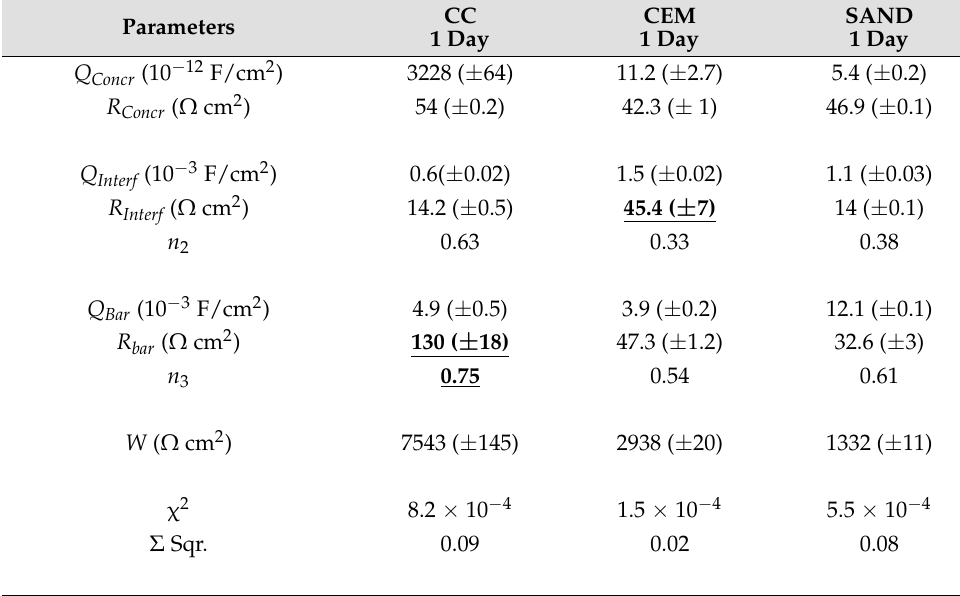
Table 3. Impedance parameters determined using equivalent circuit (EC) shown in Figure 8 with steel bars embedded in distinct concretes over 1 and 7 days.